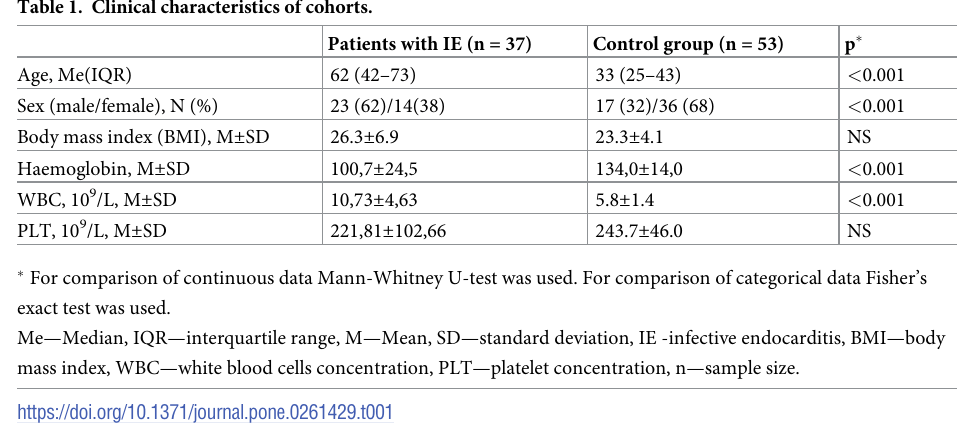
Table 1. Clinical characteristics of cohorts.